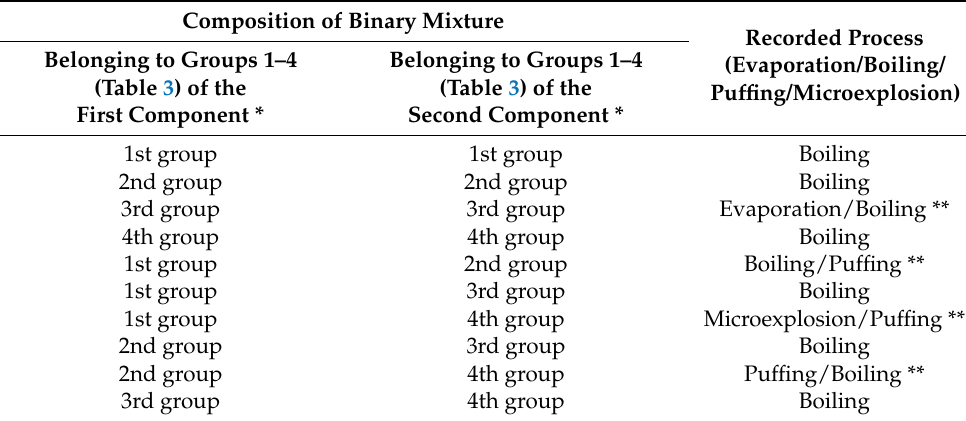
Table 4. Experimental results of the onset of evaporation, boiling, puffing, and microexplosion for binary liquid droplets subjected to high-temperature heating.